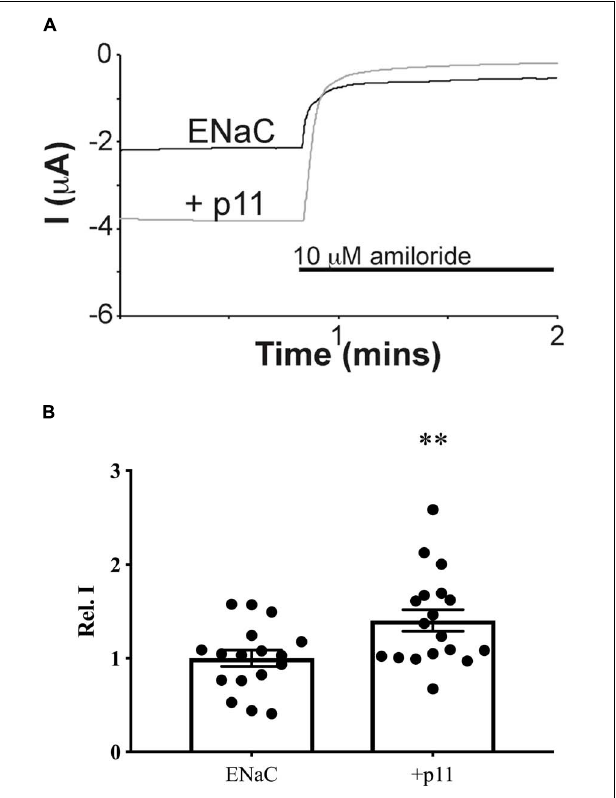
FIGURE 5 | Epithelial Na + channel current is increased by p11 co-expression. Oocytes were injected with α -, β -, and γ ENaC subunit cRNAs with or without p11 cRNA before recording whole cell Na + currents using two electrode voltage clamp. (A) Representative whole cell Na + currents from oocytes expressing ENaC alone (black line) or together with p11 (gray line) and the effect of perfusing 10 µ M amiloride. (B) Relative amiloride-sensitive currents in oocytes injected with ENaC alone ( n = 17) or together with p11 ( n = 18). Oocytes were obtained from four different batches/animals. Amiloride-sensitive currents were measured as the difference before and after addition of 10 µ M amiloride at a holding potential of –60 mV. Data are expressed as the mean ( ± SEM) fraction of amiloride-sensitive current from each oocyte relative to the ENaC control mean where ∗∗ indicates a significant difference to control at a level of p < 0.01 by unpaired t